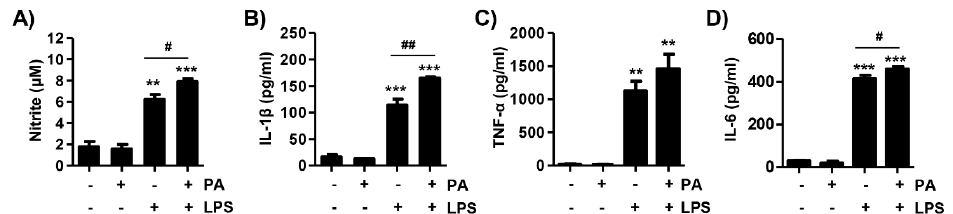
Figure 6. Lipopolysaccharide (LPS) and palmitic acid (PA) induce nitrite release and proinflammatory cytokines in primary hepatocytes. The cells were isolated from C57BL/6 mice and treated with LPS (1 μg/mL) and PA (250 μM) for 24 h. Following incubation, the cell supernatant was collected and used for analysis. ( A ) The release of nitrite was measured by Griess reagent. The absorbance was read using a microplate reader at 540 nm. Data are expressed as means ± SD ( n = 6). ( B – D ) The level of IL-1β, tumor necrosis factor (TNF)- α and IL-6 secretions was evaluated with an ELISA kit. The absorbance was read using the microplate reader at 450 nm and the optical density was calculated as described by the manufacturer’s protocols. The data are the average of three independent experiments. The results are represented by a mean ± SD ( n = 6). Statistical analysis was performed using one-way analysis of variance (ANOVA) with Tukey’s post-hoc test. ** p < 0.01 and *** p < 0.001 compared with un-treated cells. # p < 0.05 and ## p < 0.01 compared with LPS-treated cells. PA, palmitic acid; LPS,